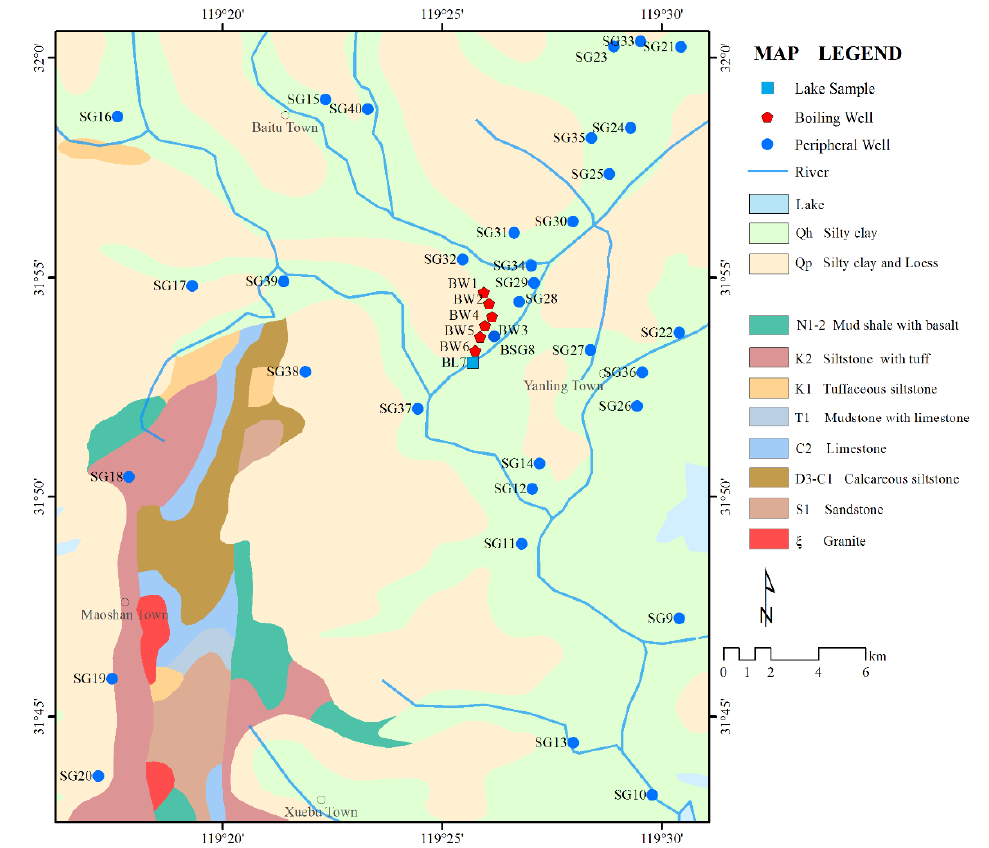
Figure 2. Geological sketch of the study area with the sample locations.